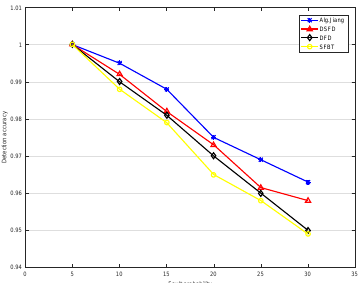
Figure 5. Detection accuracy comparison.